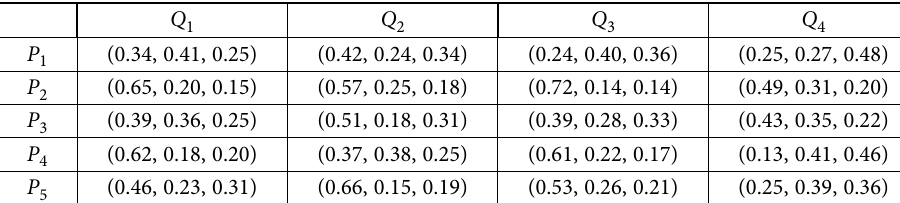
Table 1. Picture fuzzy assessing information by DM 1